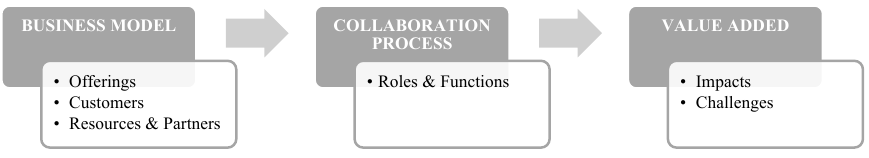
Fig. 1. Components analysed in the